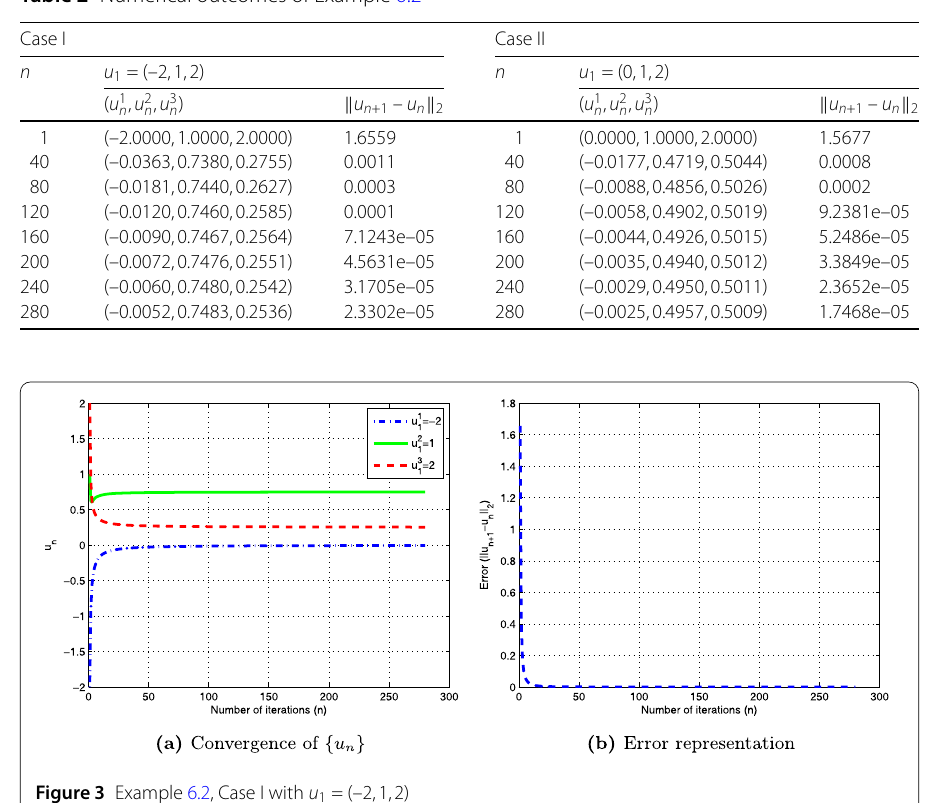
Table 2 Numerical outcomes of Example